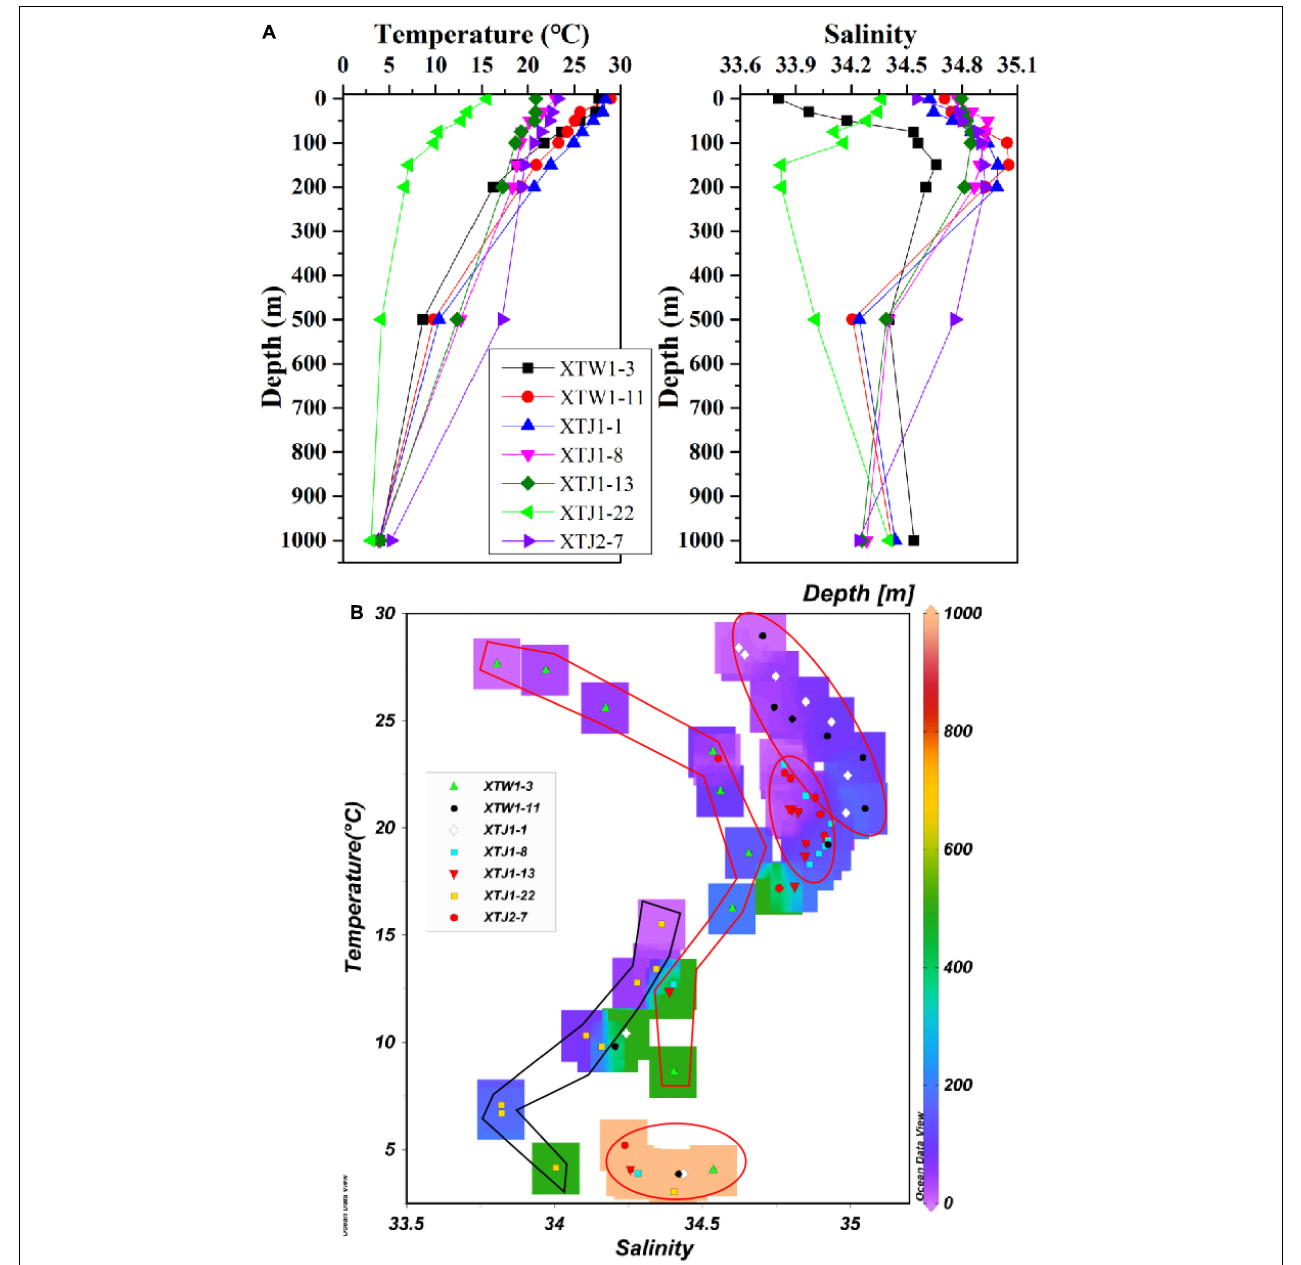
FIGURE 2 | Profiles of temperature and salinity (A) and temperature-salinity-depth diagram (B) for the samples collected in the study area.